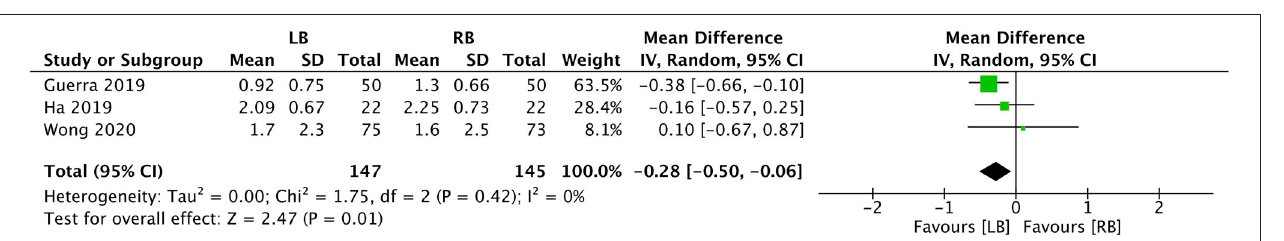
and were excluded from the analysis. Since none of the other studies assessed the accuracy of the TAP blocks, its exact influence on the review outcomes cannot be determined. Third, there was